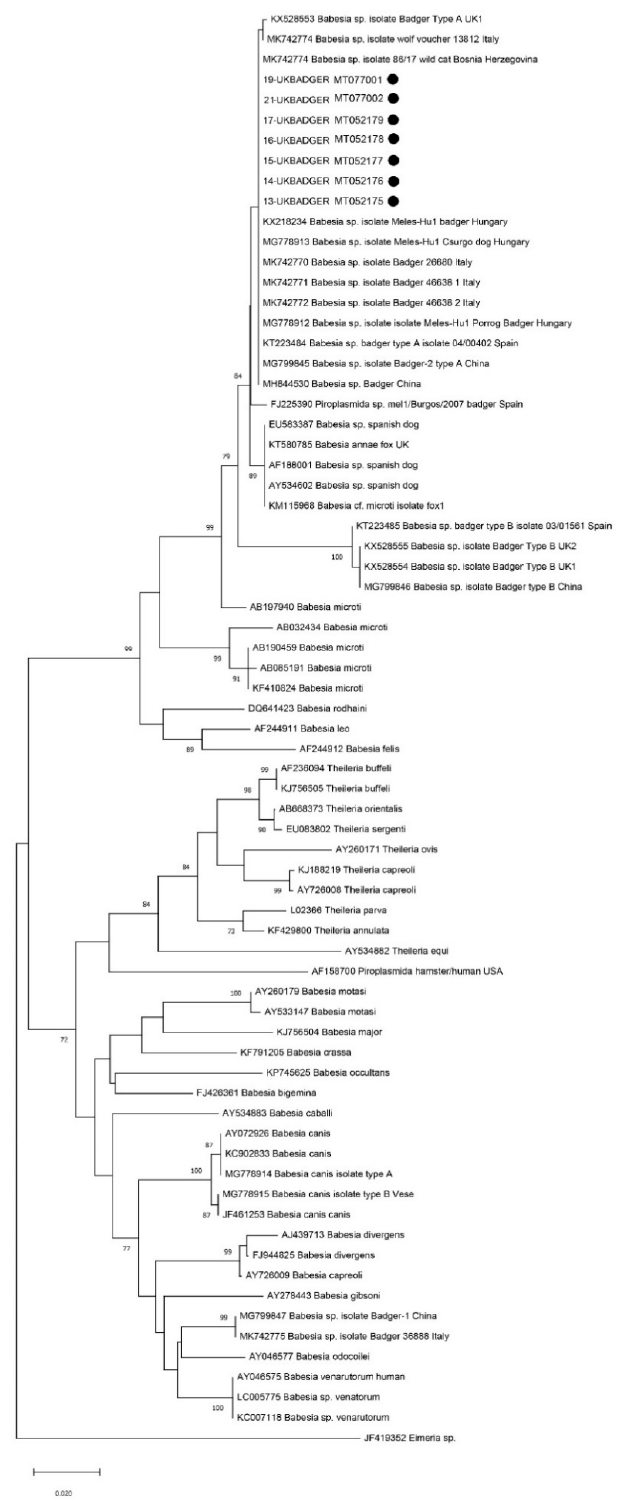
Figure 1. Neighbour ‐ joining phylogram created with 7 sequences of the small subunit (18S) ribosomal RNA gene obtained in the present survey, 19 sequences of badger ‐ associated Babesia sp. and 44 other piroplasmids sequences included in the phylogenetic analysis in recent works on Babesia sp. in badgers